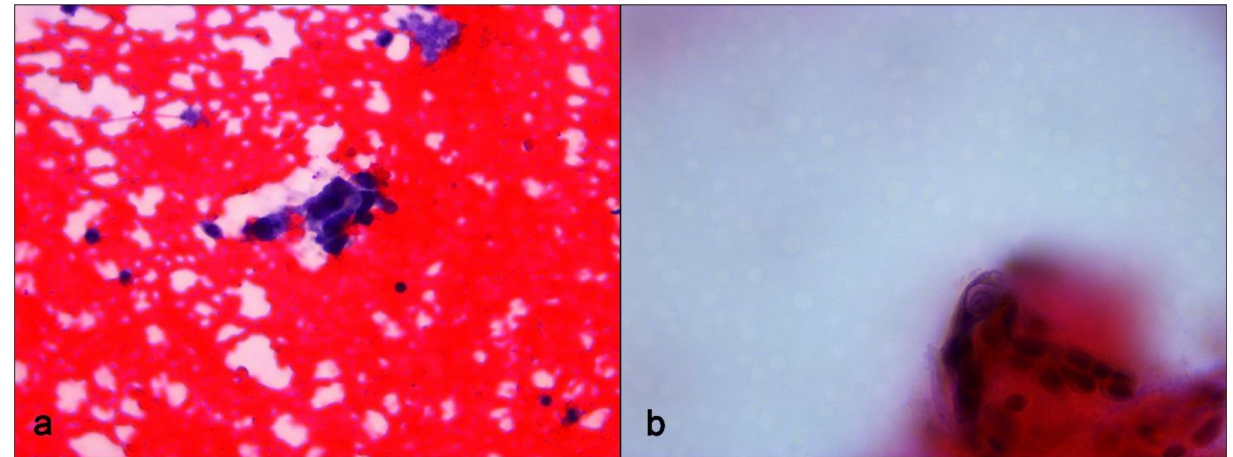
Figure 3. Fine-Needle Aspiration Cytology sampling. ( a ) Small cluster of ductal cells showing loose aggregation, irregular chromatin pattern and nuclear polymorphism. Papanicolaou stain, × 400 magnification. ( b ) Small cluster of ductal cells showing cellular details. Papanicolaou stain, × 600